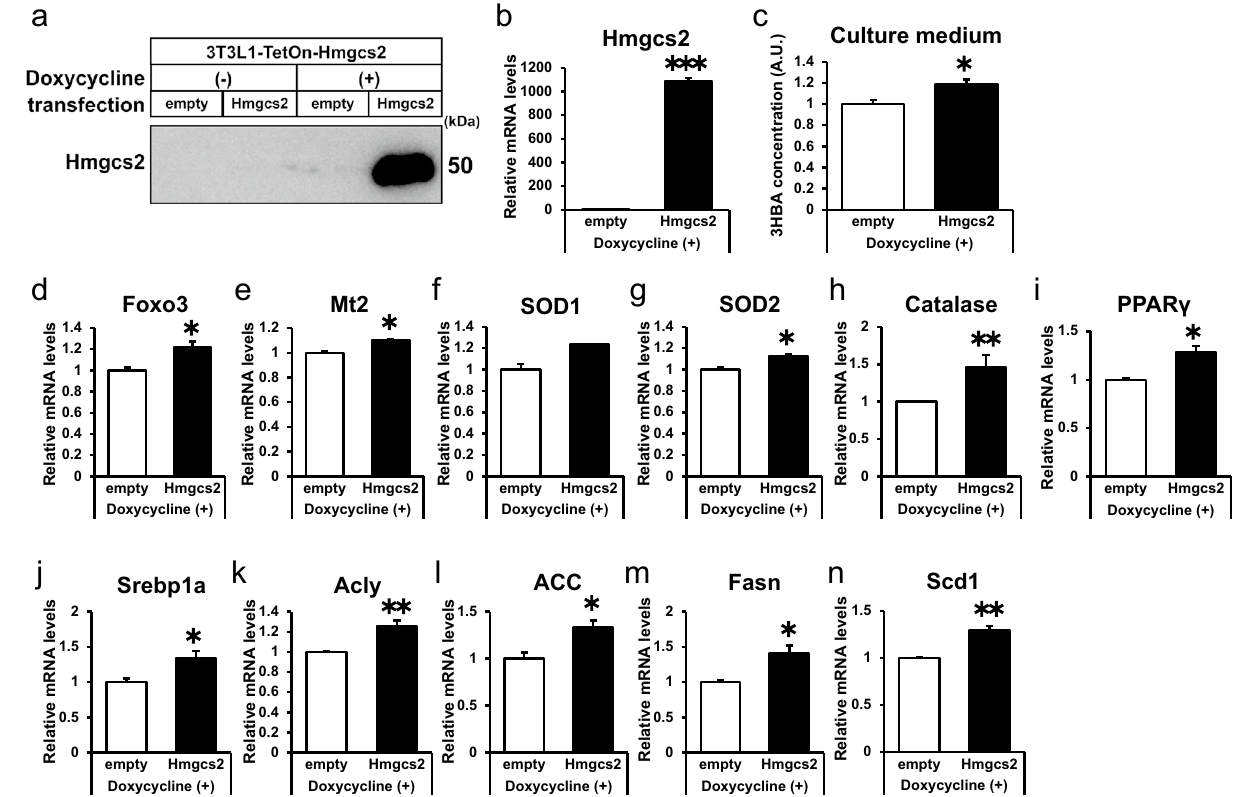
Figure 5. Overexpression of Hmgcs2 is sufficient to induce 3HBA production, antioxidative stress factors, PPARγ, and lipogenic factors in adipocytes. On day 5 after 3T3-L1-TetON-empty and 3T3-L1-TetON-Hmgcs2 adipocytes were differentiated, the adipocytes were treated with 2 µg/mL doxycycline for 48 h. On day 7 after differentiation, these adipocytes were maintained in serum-free DMEM composed of 25 mM glucose and 1 nM insulin for 24 h, followed by harvesting on day 8 after differentiation. ( a ) Western blot of Hmgcs2. n = 1. ( b ) qRT–PCR of Hmgcs2. n = 3. ( c ) 3HBA concentration in culture supernate. n = 3. ( d – h ) qRT–PCR of antioxidative stress factors. n = 3. ( i ) qRT–PCR of PPARγ. n = 3. ( j – n ) qRT–PCR of lipogenic factors. n = 3. Data are mean ± SEM. * p < 0.05, ** p < 0.01, *** p < 0.001. A.U., Arbitrary